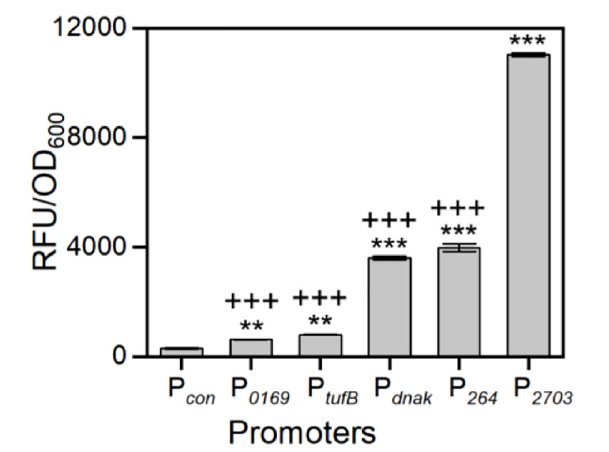
FIGURE 2 | The strength determination of screened promoters of G. oxydans WSH-003. The strength of screened promoters and microscope pictures of two shuttle promoters. (A) The strength of screened promoters as measured by evaluating mCherry activity. The abscissa axis shows the relative activity of mCherry. The ordinate axis shows different promoters of G. oxydans WSH-003. Arrows indicate the two strong shuttle promoters P 3022 and P 0943 . (B) E. coli JM109 expressing mCherry under the control of P 3022 . (C) E. coli JM109 expressing mCherry under the control of P 0943 . (D) G. oxydans WSH-003 expressing mCherry under the control of P 3022 . (E) G. oxydans WSH-003 expressing mCherry under the control of P 0943